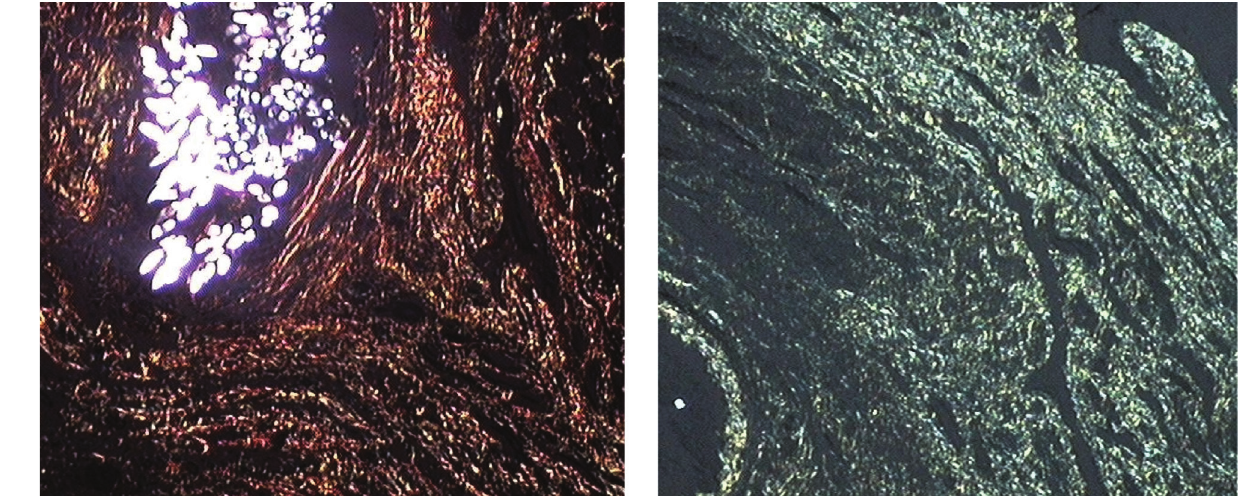
Figure-3 - Histological method of sirius red f3ba